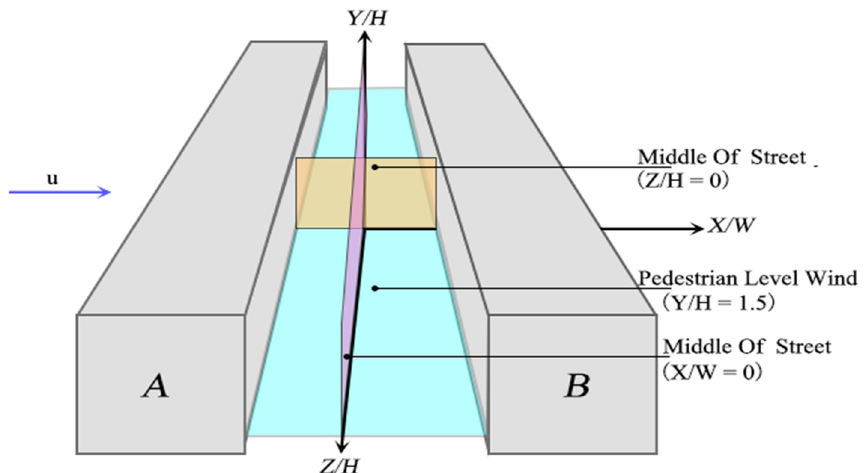
Figure 8. Schematic diagram of the monitoring plane.